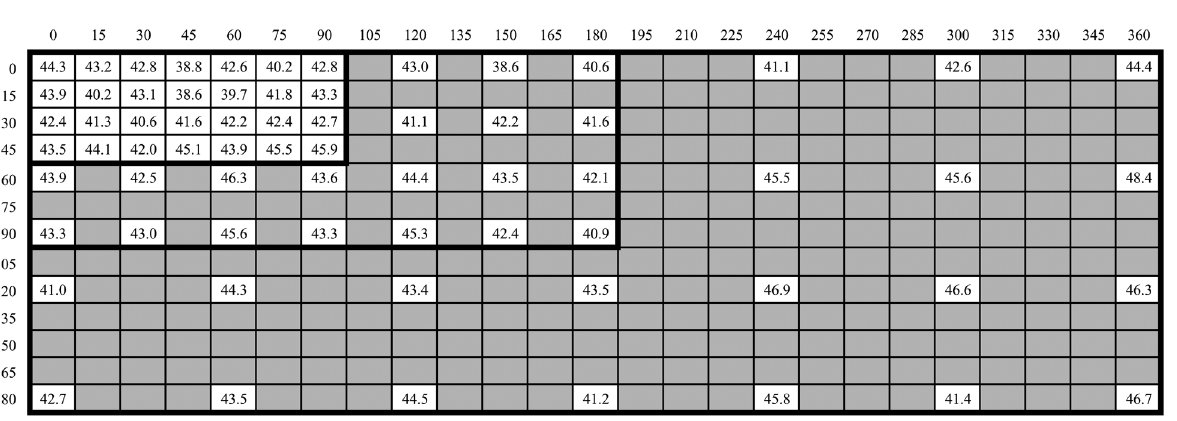
Fig. 2. Arrangement of the testing locations together with the average values of the rebound indices for the N-type original Schmidt rebound hammer